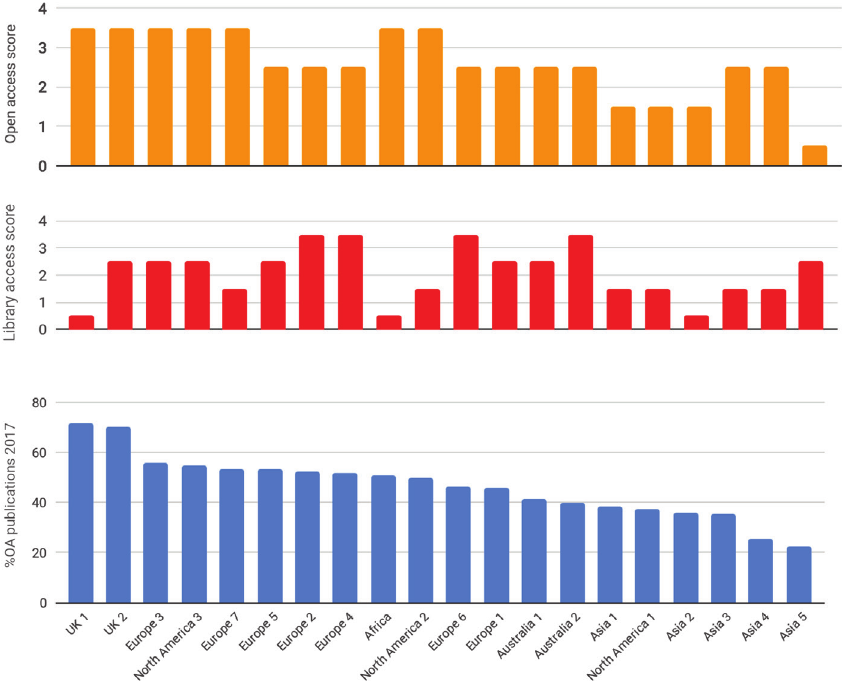
Fig. 5: Percentage of 2017 OA publications, Open access scores and Library access scores for each university. Source of OA publications data: Microsoft Academic, Scopus, Web of Science, Unpaywall, Crossref. Curtin Open Knowledge Initiative,